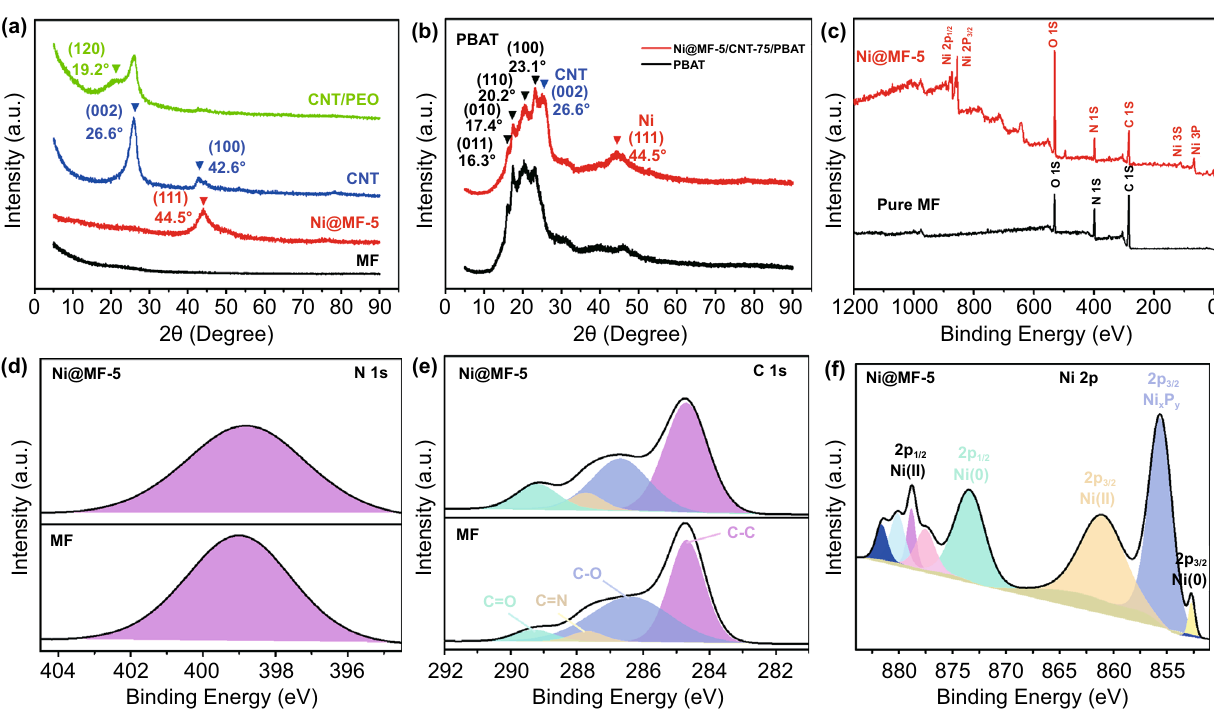
Fig. 2 Structure characterization of samples. a XRD patterns of MF, Ni@MF-5, CNT, and CNT/PEO. b XRD patterns of PBAT and Ni@ MF-5/CNT-75/PBAT. c Full-range XPS spectra of MF and Ni@MF-5. d Narrow N 1 s core-level XPS spectra of MF and Ni@MF-5. e Narrow C 1 s core-level XPS spectra of MF and Ni@MF-5. f Narrow Ni 2p core-level XPS spectrum of